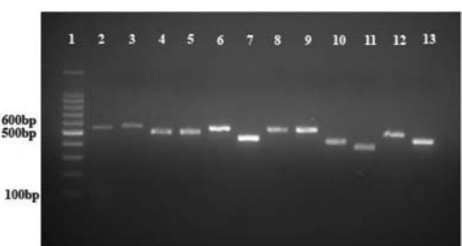
Fig. 3. Agarose gel electrophoresis of PCR amplified products of VP1, VP2 and VP3 genes of IBD/CVAS/6.